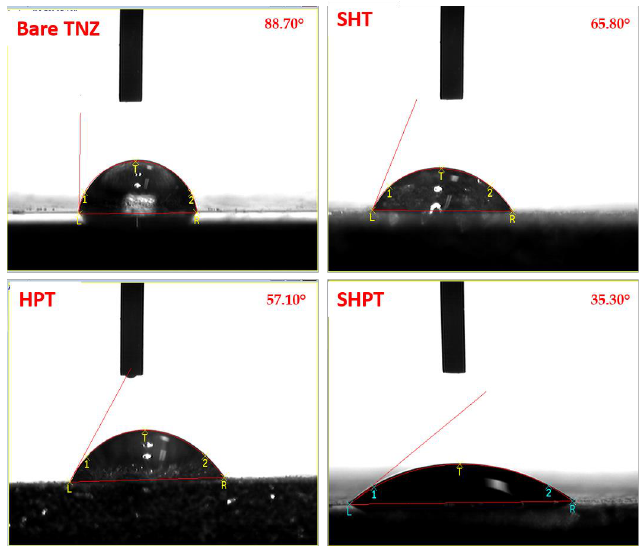
Figure 4. WCA images of treated specimens.